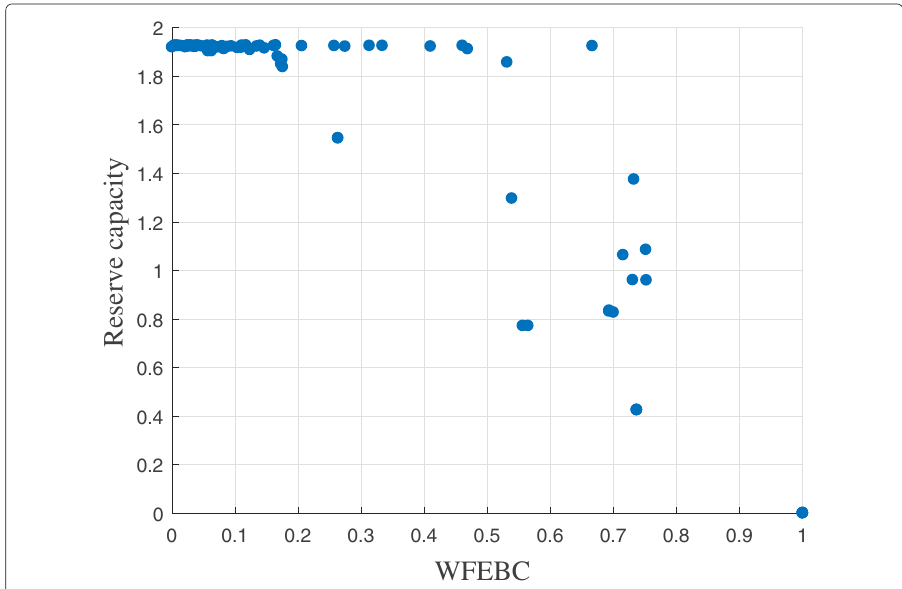
Fig. 4 Analysis of the correlation between reserve capacity and WFEBC links values for Net3. The reserve capacity of the individual links of Net3 is plotted against their WFEBC value